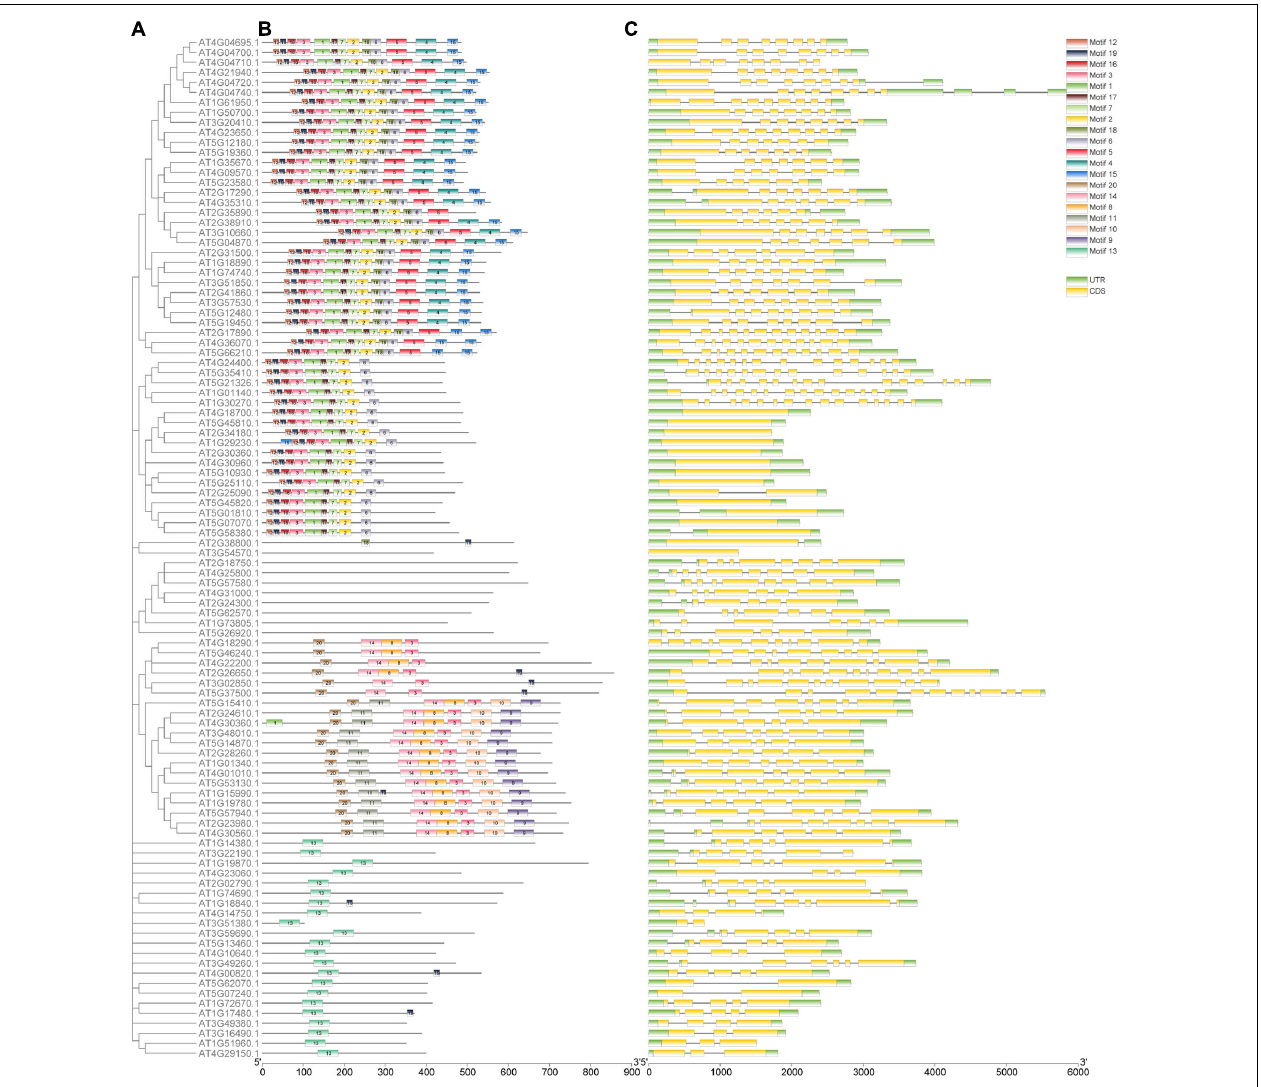
FIGURE 2 | Phylogenetic relationship, structure, and encoded conserved motifs of the 102 genes in calcium-related gene families. (A) Phylogenetic tree constructed based on the full-length protein sequences with MEGA-X software. (B) Motif composition of proteins associated with calcium. Motifs 1–20 are displayed in various colored boxes. (C) Exon-intron structures of the 102 genes in calcium-related gene families. The untranslated regions were colored in green while the exons regions were colored in